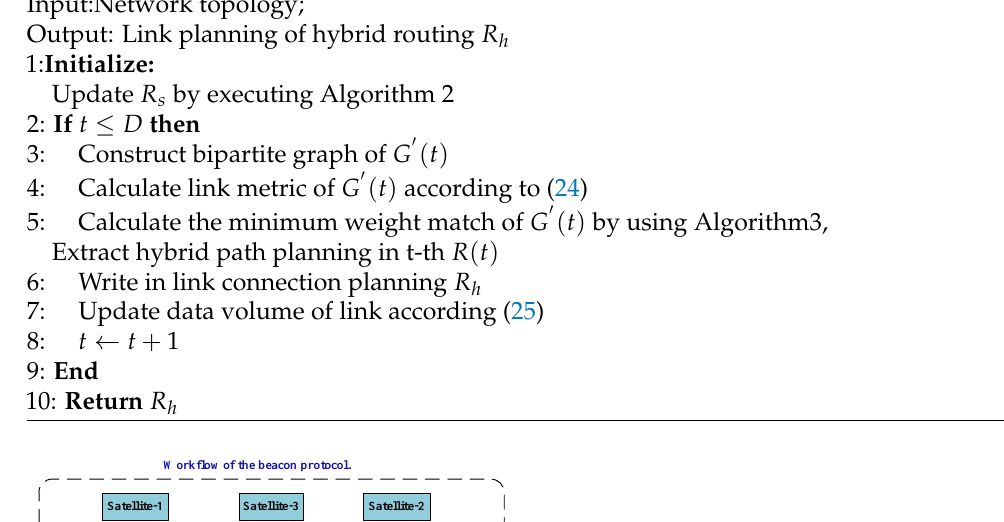
Algorithm 4 KM-based Link-state Aware Terrestrial-Satellite Hybrid Routing algorithm